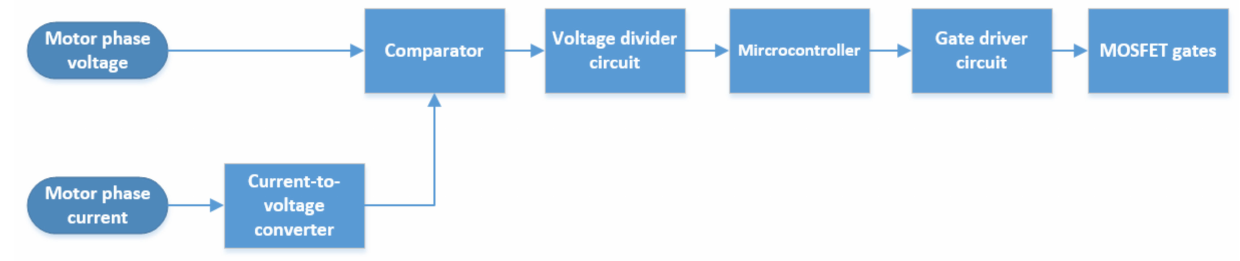
Figure 11. Generation concept of gate signals.